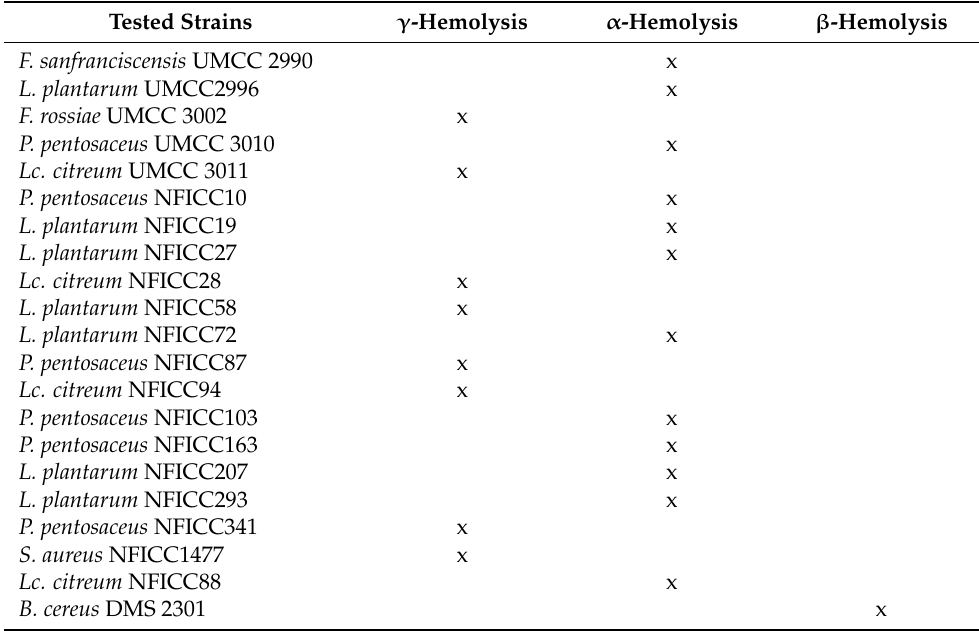
Table 5. Hemolytic capacity * of the tested